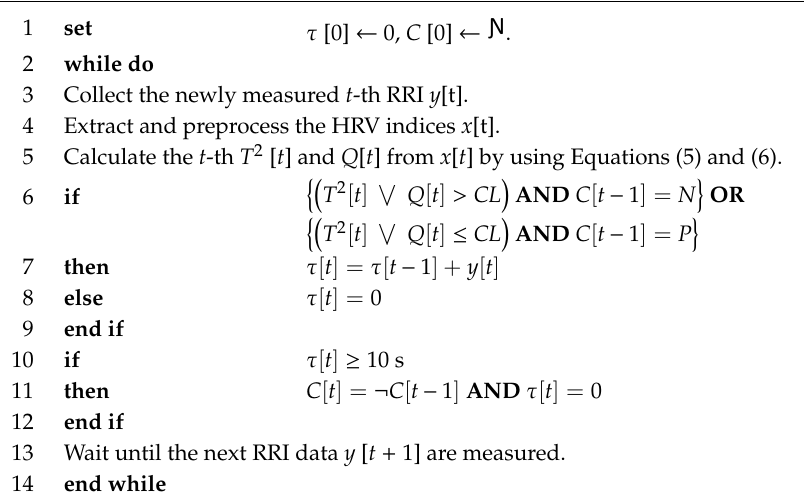
Algorithm 1 Seizure prediction